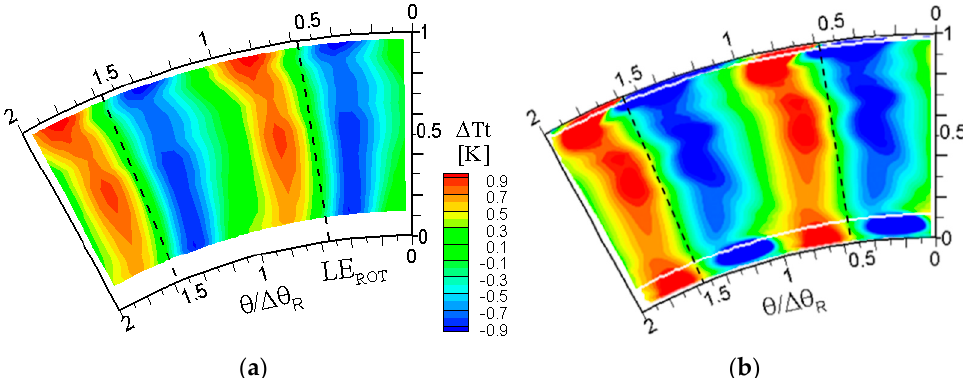
Figure 13. Amplitude of the periodic fluctuations of total temperature upstream of the rotor due to rotor-driven perturbation; ( a ) estimated from total pressure measurements; ( b ) predicted by CFD.